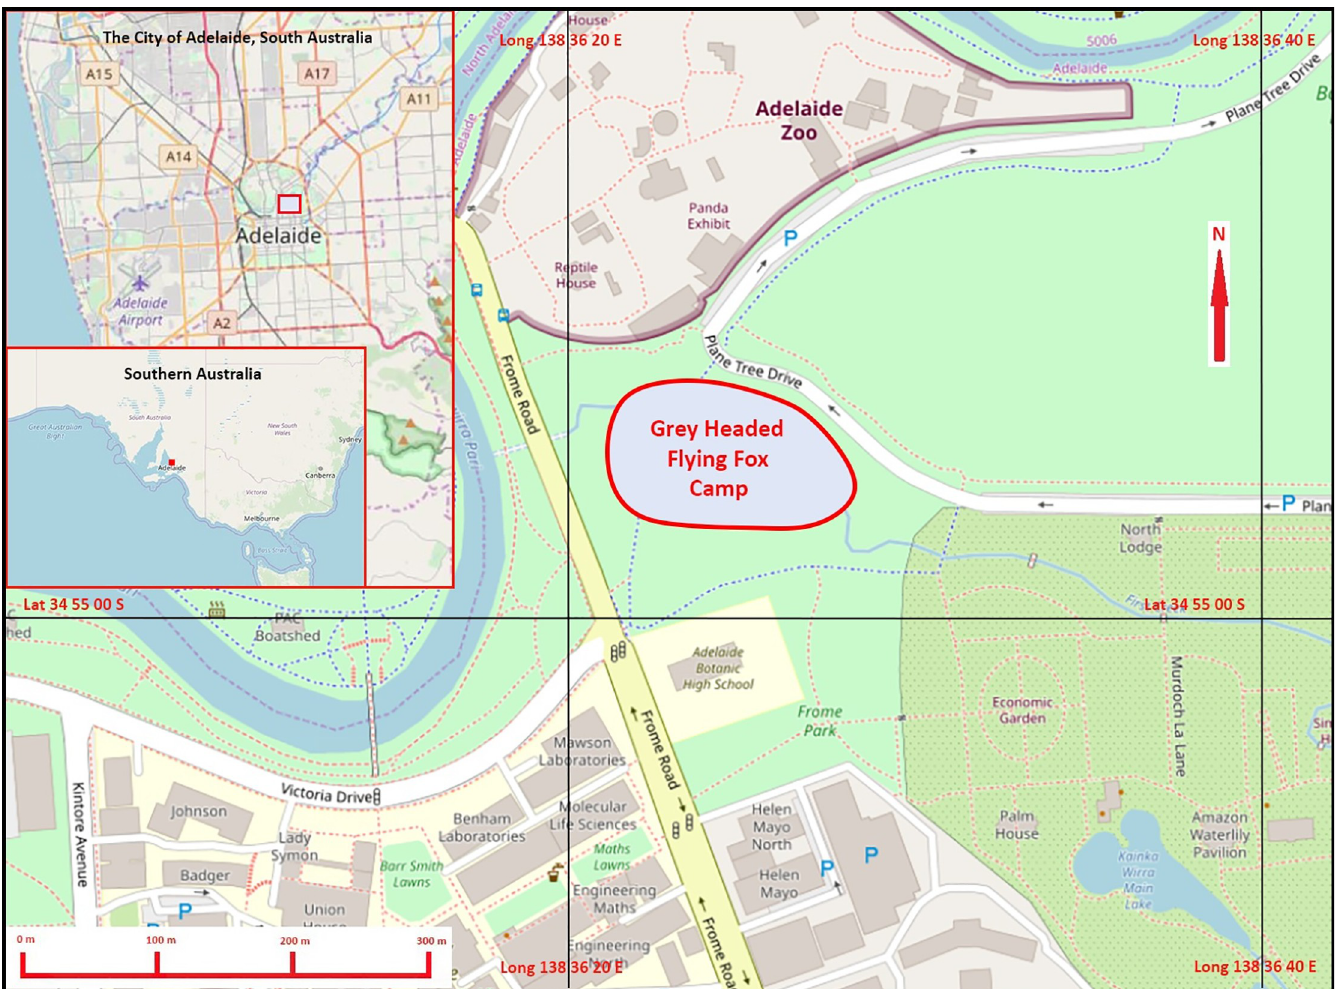
Fig 1. Location of the Grey-headed flying fox camp in Adelaide’s Botanic Park and relationship to central Adelaide and Southern Australia.